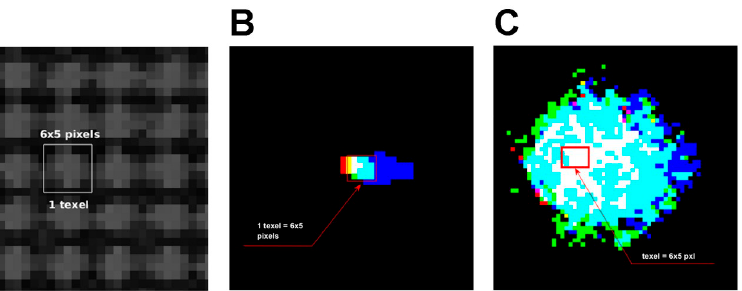
Fig 3. Textel projection on image. A: Greyscale image of white illuminated texels with no diffuser. The white box is the image of one texel acquired by the camera. Both images (B and C) show non-zero wavelength intensity values instead of intensities values. B: Image of the each RGB channel of one texel with no diffuser. C: Image of one texel with a diffuser.